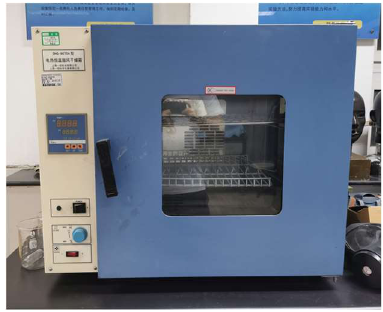
Figure 2. The DHG-9070A drying oven.